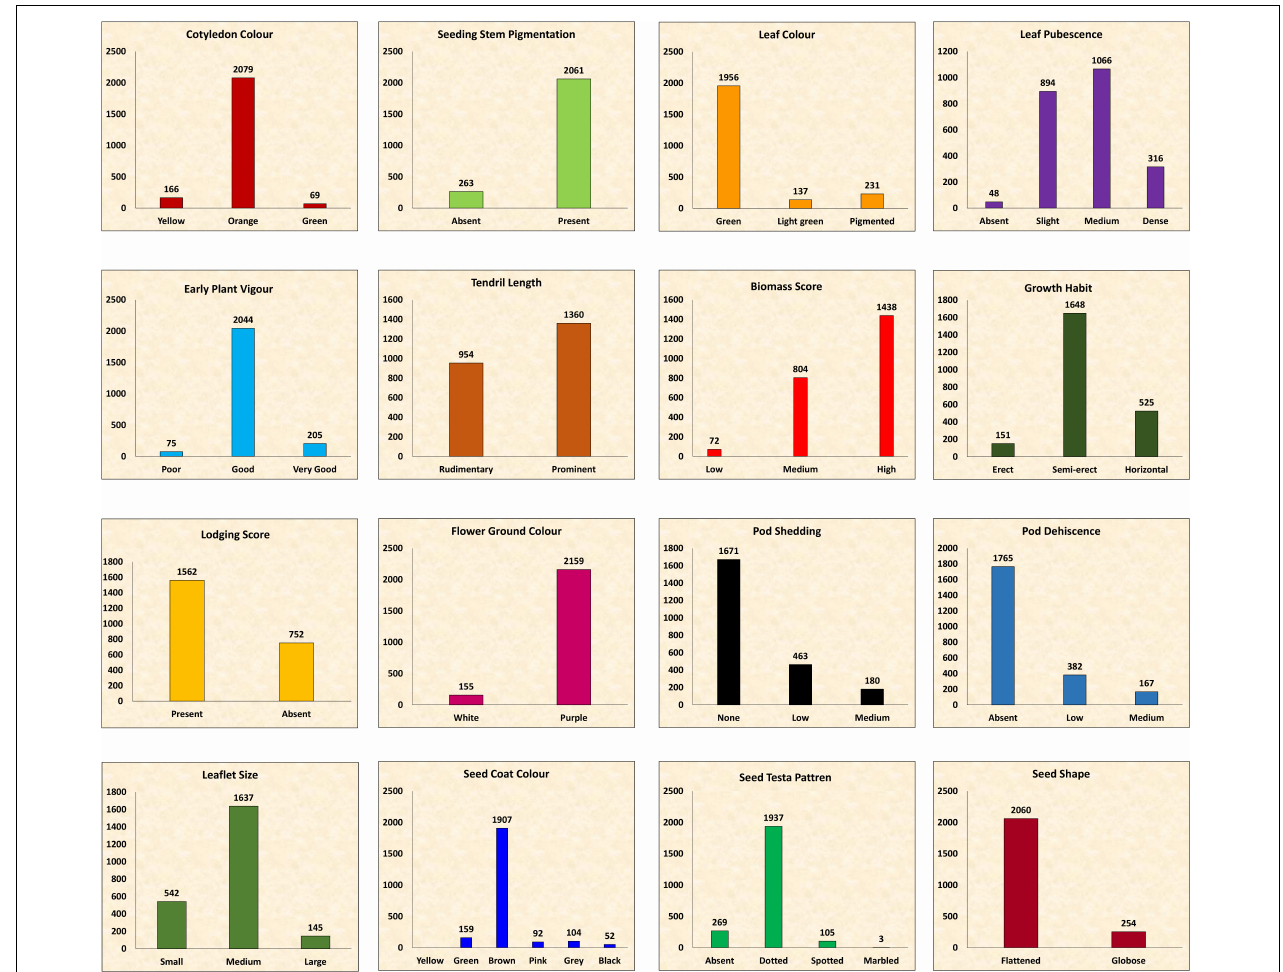
FIGURE 4 | Frequency distribution of entire lentil germplasm for qualitative